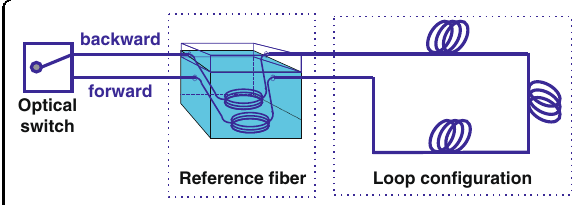
Fig. 4 Loop con fi guration scheme using reference fi ber in Raman distributed optical fi ber